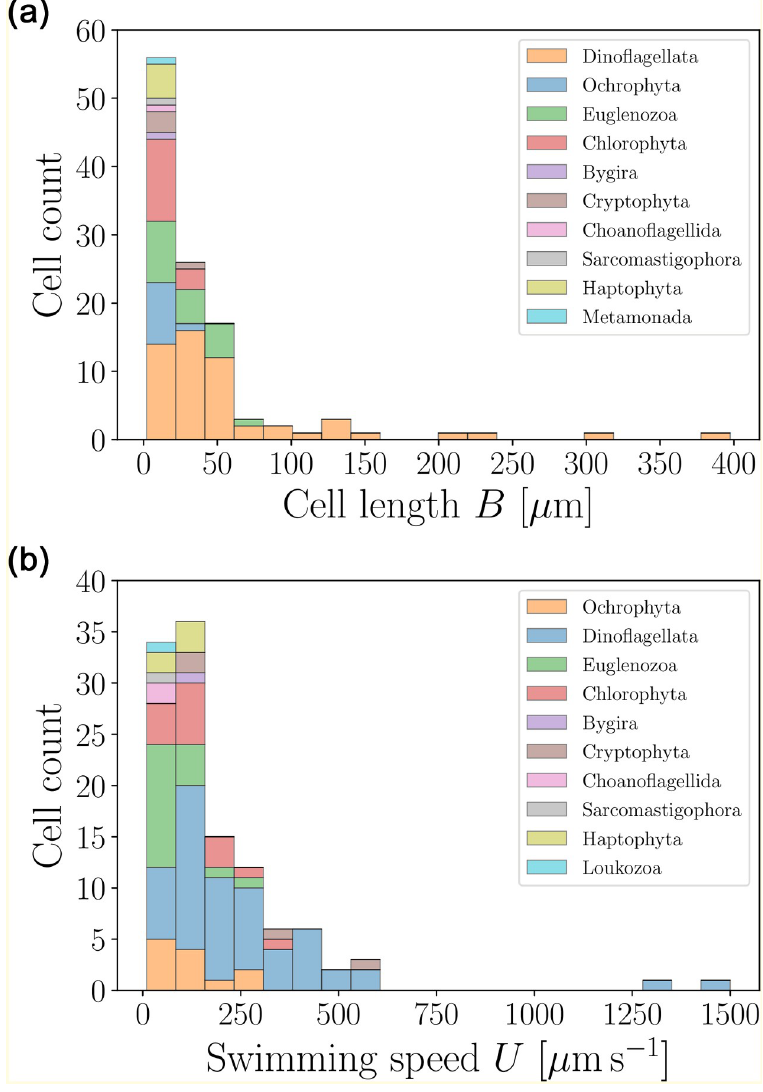
Fig 8. Histograms of body lengths, B ( μ m, left), and swimming speeds, U ( μ m s − 1 , right), for flagellated eukaryotic swimmers (excluding spermatozoa and ciliates) in our dataset. The average cell length is h B i = 38.87 ± 56.64 μ m ( n = 113) and the average swimming speed h U i = 186.70 ± 208.77 μ m s − 1 ( n = 116).